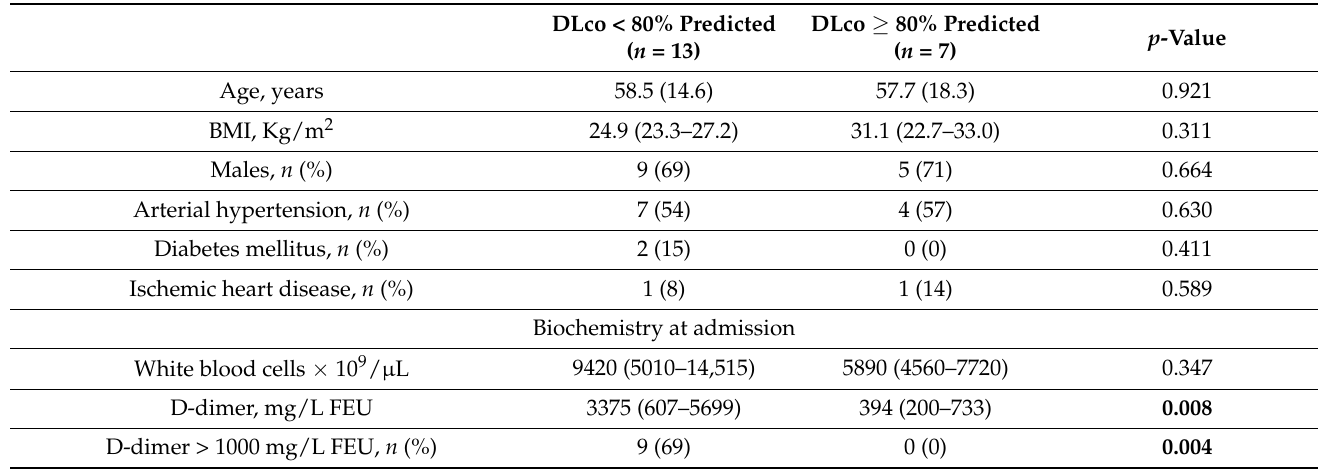
Table 3. Clinical characteristics during hospitalization in patients with DLco ≥ 80% predicted and DLco < 80%